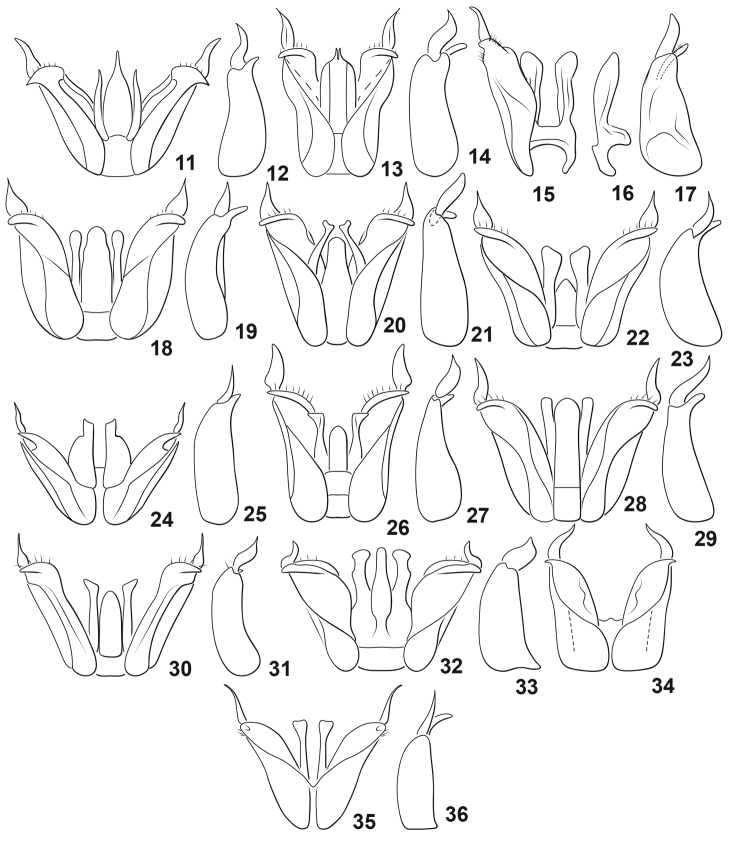
Desmopachria species, male genitalia. 11, 12D.
aspera11 dorsal aspect 12 right lateral lobe, right lateral aspect 13, 14D.
cenchramis13 dorsal aspect 14 right lateral lobe, right lateral aspect 15–17D.
challeti15 median lobe and right lateral lobe, dorsal aspect 16 median lobe, right lateral aspect 17 right lateral lobe, right lateral aspect 18, 19D.
ciruclaris18 dorsal aspect 19 right lateral lobe, right lateral aspect 20, 21D.
aspera20 dorsal aspect 21 right lateral lobe, right lateral aspect 22, 23D.
defloccata22 dorsal aspect 23 right lateral lobe, right lateral aspect 24, 25D.
glabella24 dorsal aspect 25 right lateral lobe, right lateral aspect 26, 27D.
grana26 dorsal aspect 27 right lateral lobe, right lateral aspect 28, 29D.
isthmia28 dorsal aspect 29 right lateral lobe, right lateral aspect 30, 31D.
laesslei30 dorsal aspect 31 right lateral lobe, right lateral aspect 32, 33D.
lewisi32 dorsal aspect 33 right lateral lobe, right lateral aspect 34D.
majuscula, dorsal aspect 35, 36D.
tarda35 dorsal aspect 36 right lateral lobe, right lateral aspect. Redrawn from Young (1981).